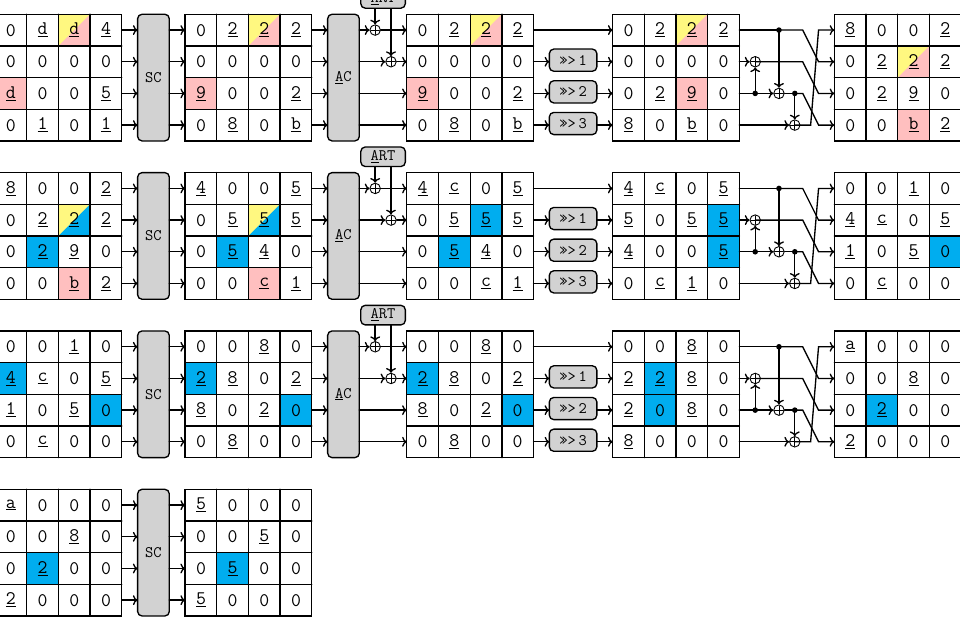
Figure 4: The first four rounds of the differential characteristic in “Boomerang Distin- guisher II for SKINNY-64-128 from [HBS21]. Each line represents a single round of the SKINNY round function. The cells highlighted in yellow and pink form linear constraints on the round key and the cells highlighted in blue form a nonlinear constraint. All the active cells are